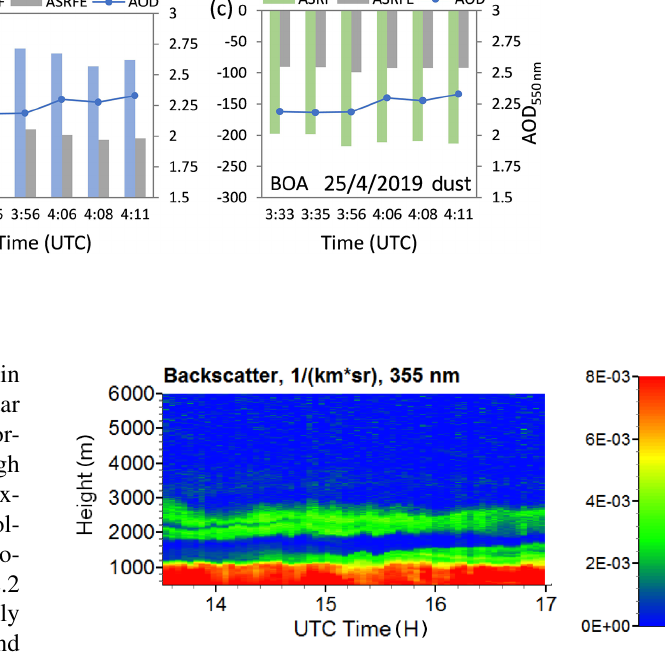
Figure 8. The backscattering coefficient profiles at 355nm for the two-layer dust case on the night of 8 April